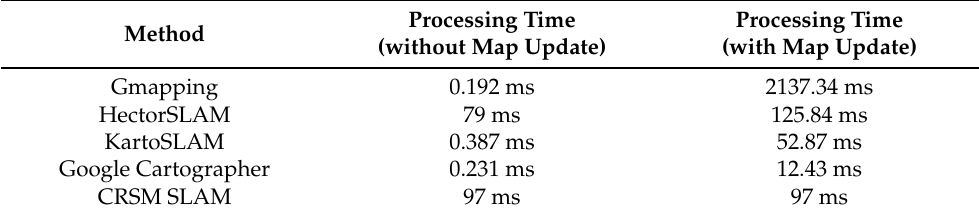
Table 6. The processing time of 2D SLAM algorithms on a pre-recorded dataset [62] and with the default parameter values. Sensor height: 60 cm; resolution: 0.4 ◦ ; horizontal FoV: 360 ◦ ; and frequency: 10 Hz.